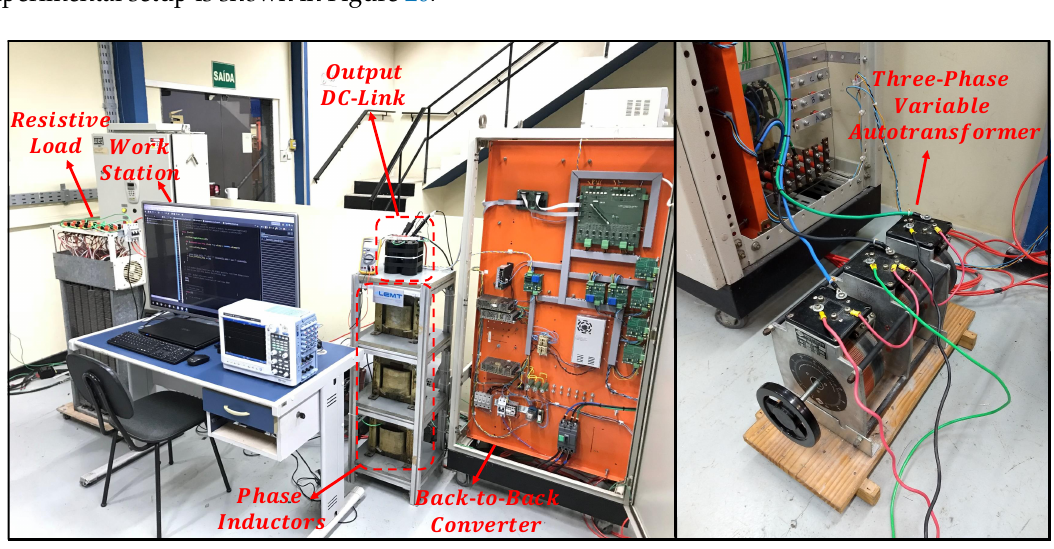
Figure 20. Experimental test bench